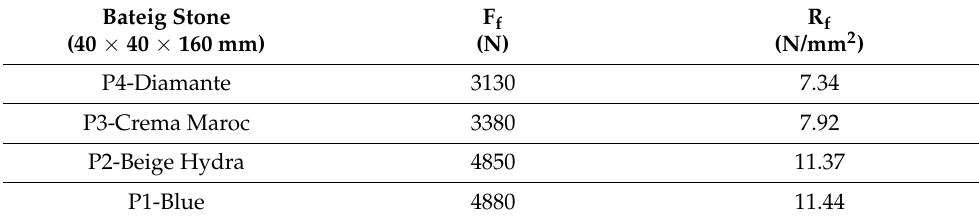
Table 4. Flexural strength test: unconsolidated Bateig stone specimens (mean values). Bateig